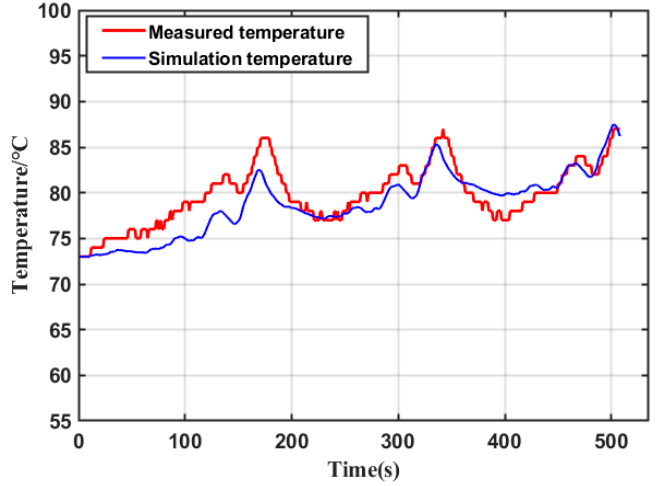
Figure 12. Comparison of simulated and measured temperatures.